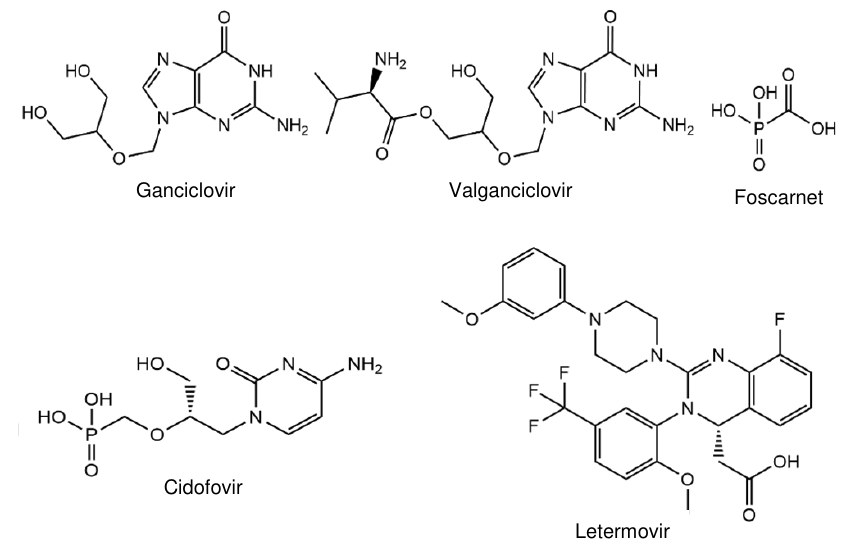
Figure 1. Structures of approved drugs against human cytomegalovirus (HCMV).